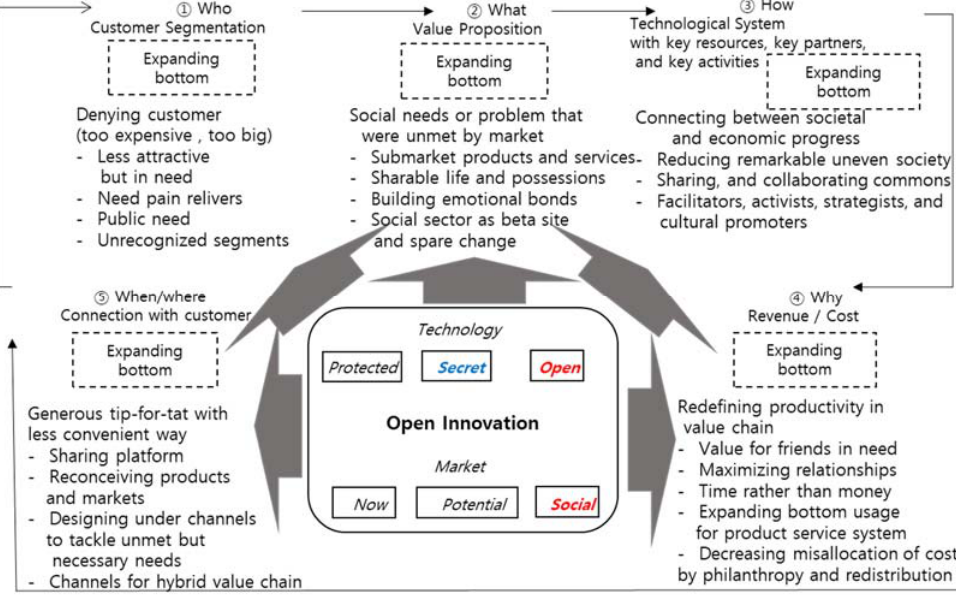
Figure 4. Expanding the bottom rectangular concept model for social entrepreneur-centered business model